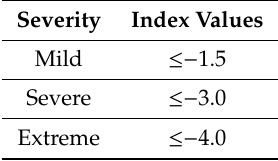
Table 2. Table showing Drought Severity Index